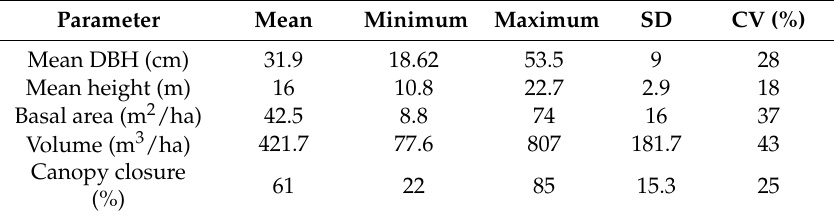
Forest structural characteristics derived from reference data in the study area (DBH = diameter at breast height, SD = standard deviation, CV = coefficient of variation). Parameter Mean Minimum